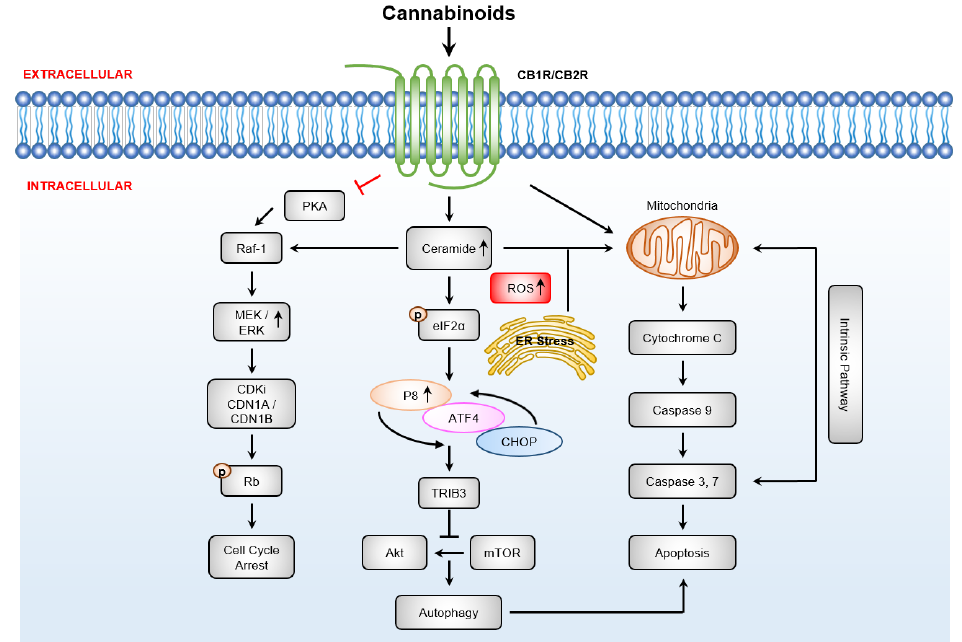
Figure 3. Anti-cancer effects and cell death pathways regulated by cannabinoids and the classical cannabinoid receptors. The activation of cannabinoid receptors (CBRs) drives sustained extracellular signal-regulated kinases (ERK) activity driving reactive oxygen species (ROS) production and leads to activation of cyclin kinase inhibitors resulting in G1 cell cycle arrest [45,115]. Agonism of cannabinoids receptors increases ceramide synthesis to induce endoplasmic reticulum (ER) stress driving phosphorylation and activity of the transcription factor eukaryotic translation initiation factor 2A (eIF2 α ), leading to upregulation of p8 and its downstream targets cyclic AMP-dependent transcription factor ATF-4 (ATF4), C / EBP homologous protein (CHOP), and tribbles homolog 3 (TRIB3). Activation of p8 inhibits the Akt / mTORC1 axis, driving autophagy-mediated cell death pathway upstream of apoptosis